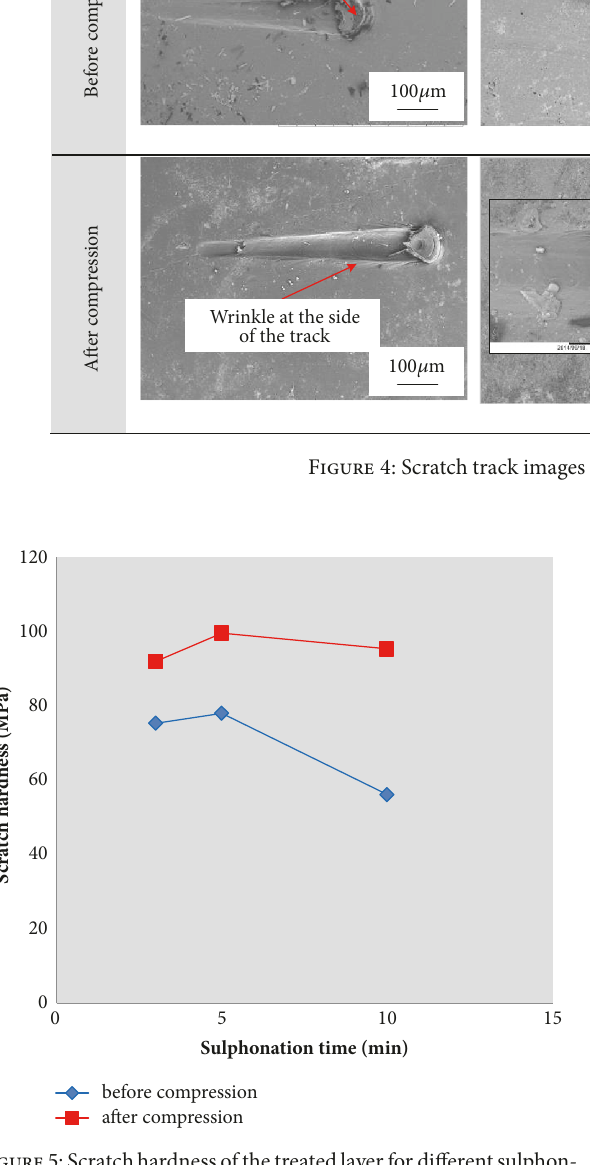
Figure 5: Scratchhardness of the treatedlayer for differentsulphon- ation time, without and with applying compression